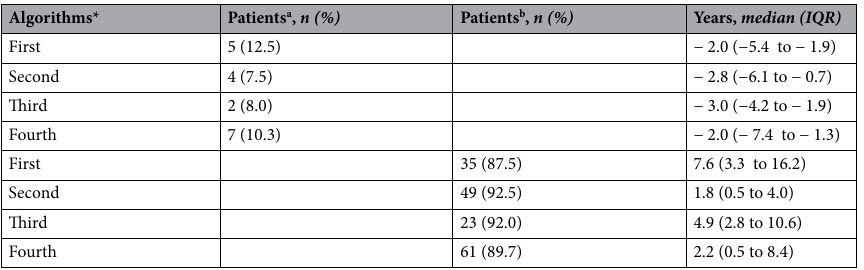
Table 2. Median time elapsed between the date of assumed rheumatoid arthritis diagnosis recorded in the administrative databases and the actual one in the medical charts. *Out of patients with the first supply of bDMARD from 2014 to 2016 and at least one record of visit at the Rheumatology Unit of Pisa University Hospital from 2013 to the index date, we tested the performance of four index tests (algorithms): First) RA according to hospital discharge records or emergency department admissions (ICD-9 code, 714*); Second) RA according to exemption code from co-payment (006); Third) RA according to hospital discharge records or emergency department admissions (ICD-9 code, 714*) AND RA according to exemption code from co-payment (006); Fourth) RA according to hospital discharge records or emergency department admissions (ICD-9 code, 714*) OR RA according to exemption code from co-payment (006). a Patients with RA diagnosis recorded firstly in the administrative database. b Patients with RA diagnosis recorded firstly in the medical charts. IQR interquartile range, n number, RA rheumatoid